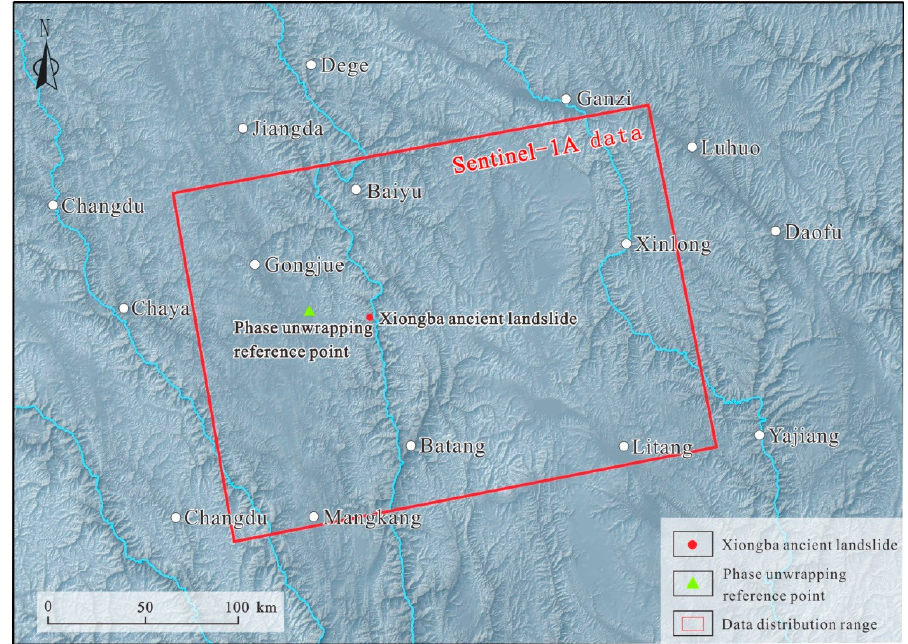
Figure 5. Data coverage map of Sentinel-1A in this study. Table 1. The basic parameters of SAR image data.